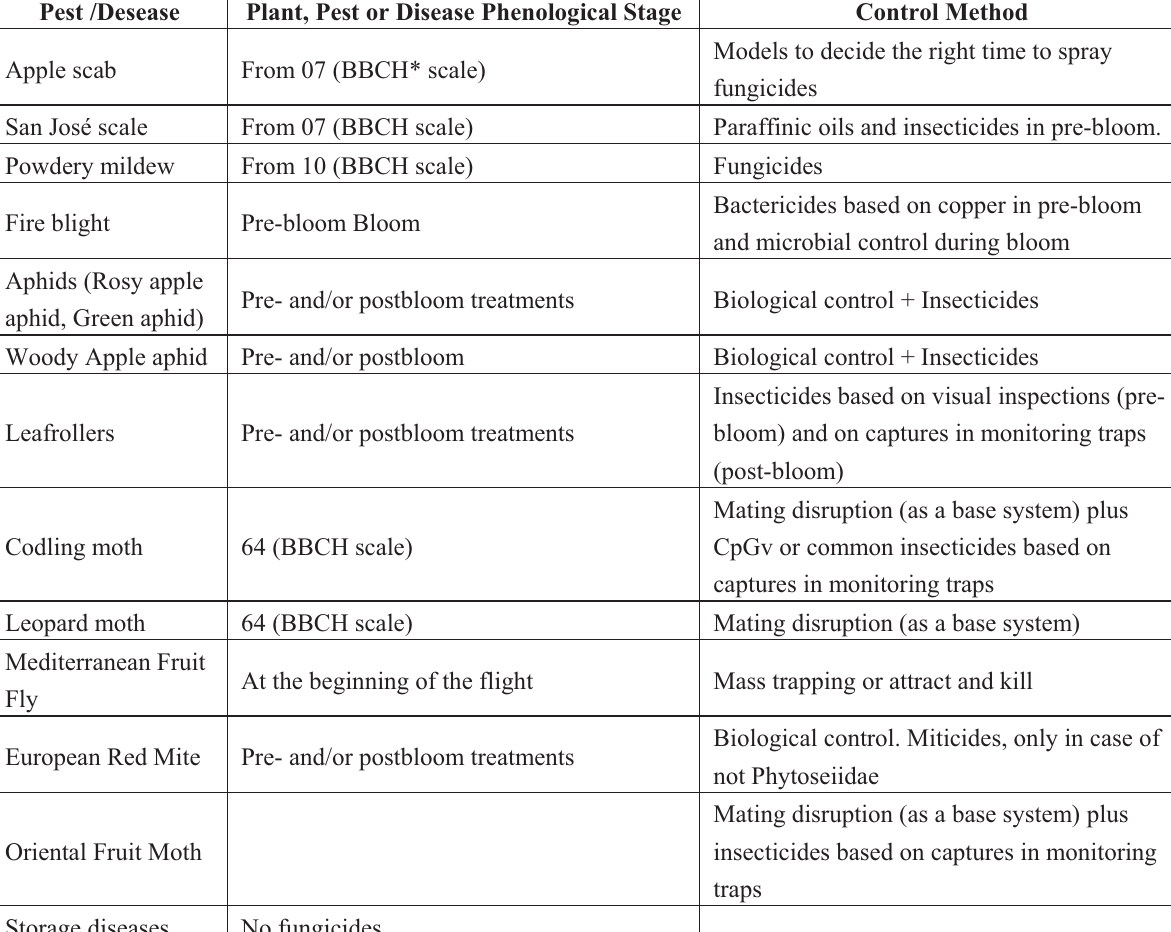
Table 2. Common pests and diseases of apple in chronological order of appearance until harvest; right moment to start control and control methods for